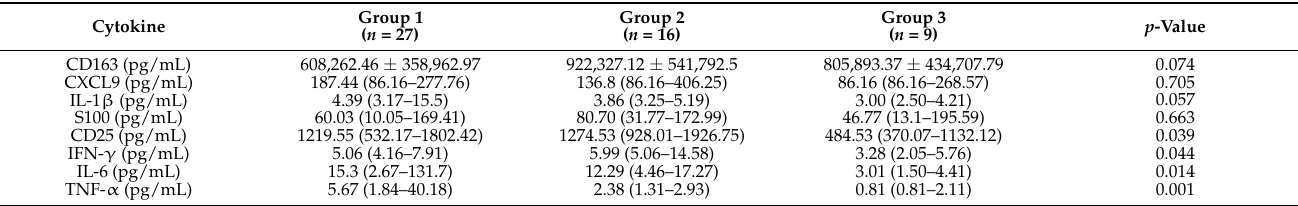
Table 3. Cytokine profiles in COVID-19 children (Group 1), children with other infectious (Group 2), and children without infectious diseases (Group